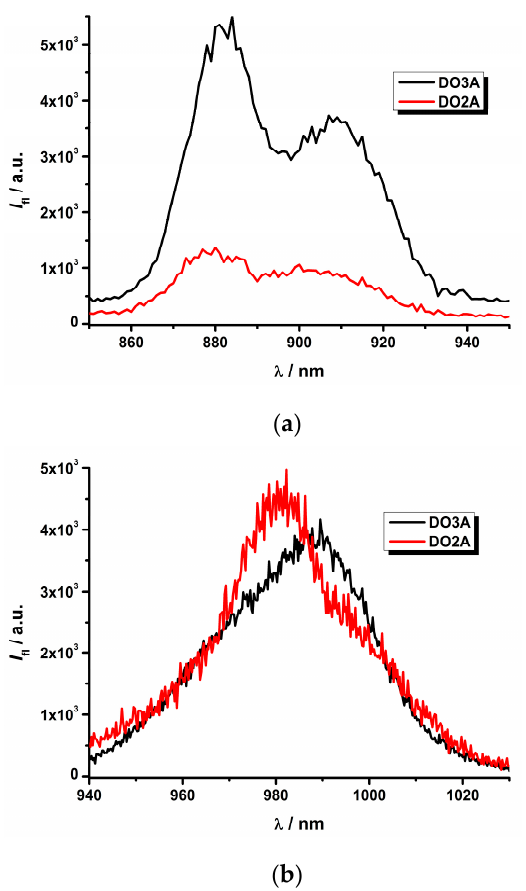
Figure 3. The antenna effect of ternary Nd(III) ( a ) and Yb(III) ( b ) complexes with DO2A and DO3A macrocyclic and IQCA ligands ( λ exc = 325 nm, pH = 7.5 (40 mM HEPES), c Ln ~ 0.2 mM, c DO3A ~ 0.3 mM / c DO2A ~ 0.4 mM, c IQCA ~0.35 / 0.7 mM for Ln(III) complexes with DO3A and DO2A ligands.